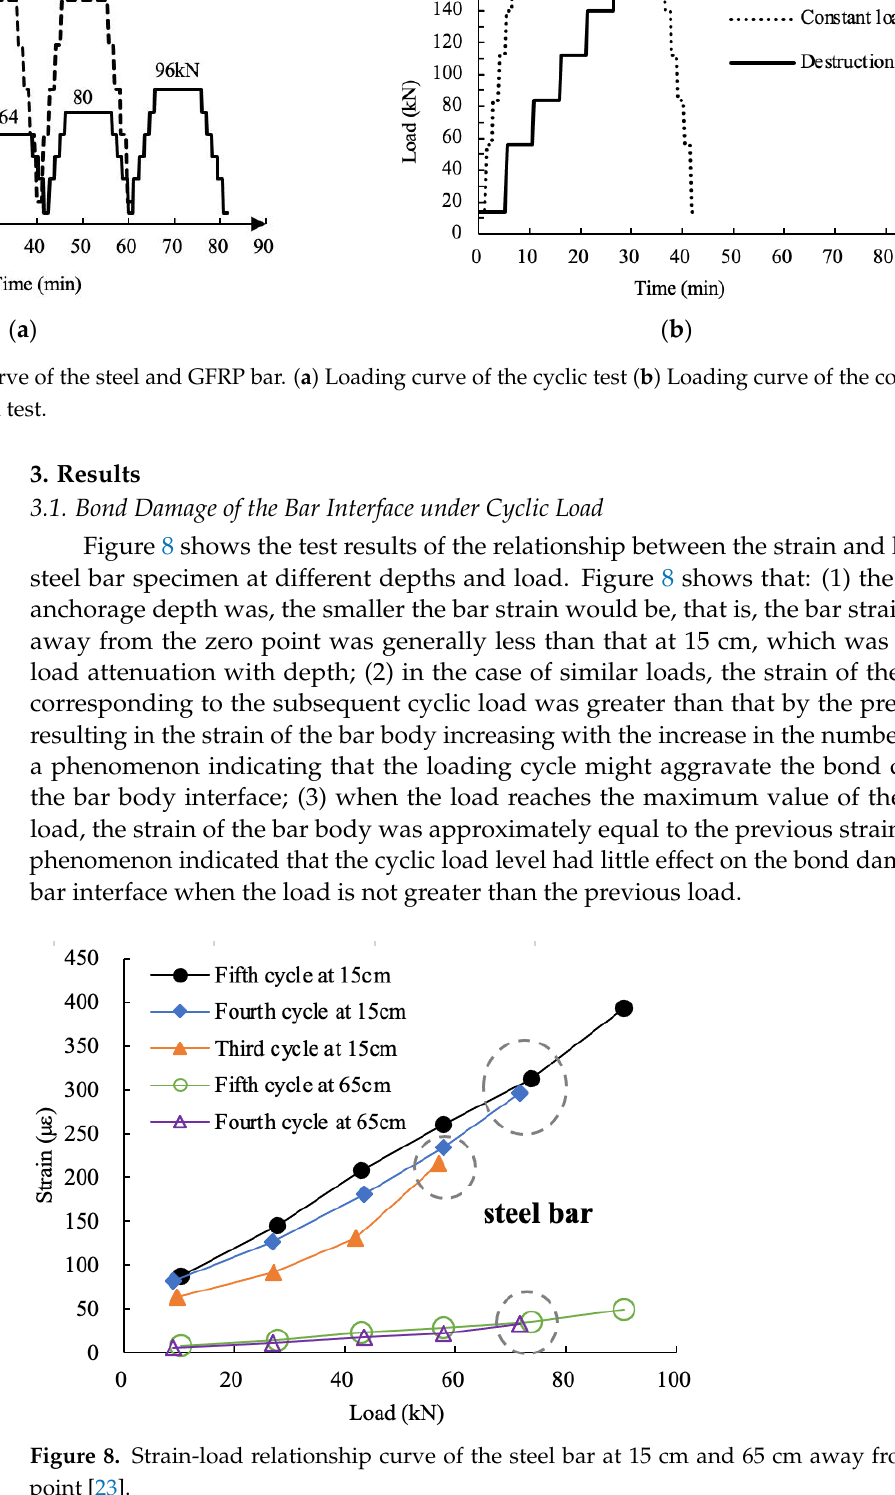
Figure 7. Test loading curve of the steel and GFRP bar. ( a ) Loading curve of the cyclic test ( b ) Loading curve of the constant load test and destruction test